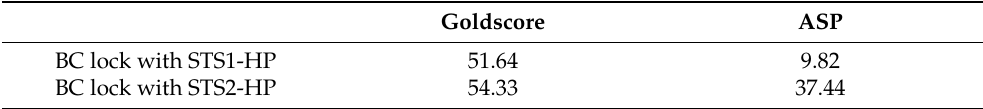
Table 2. Docking scoring function of baicalein with STS1 and STS2 HP